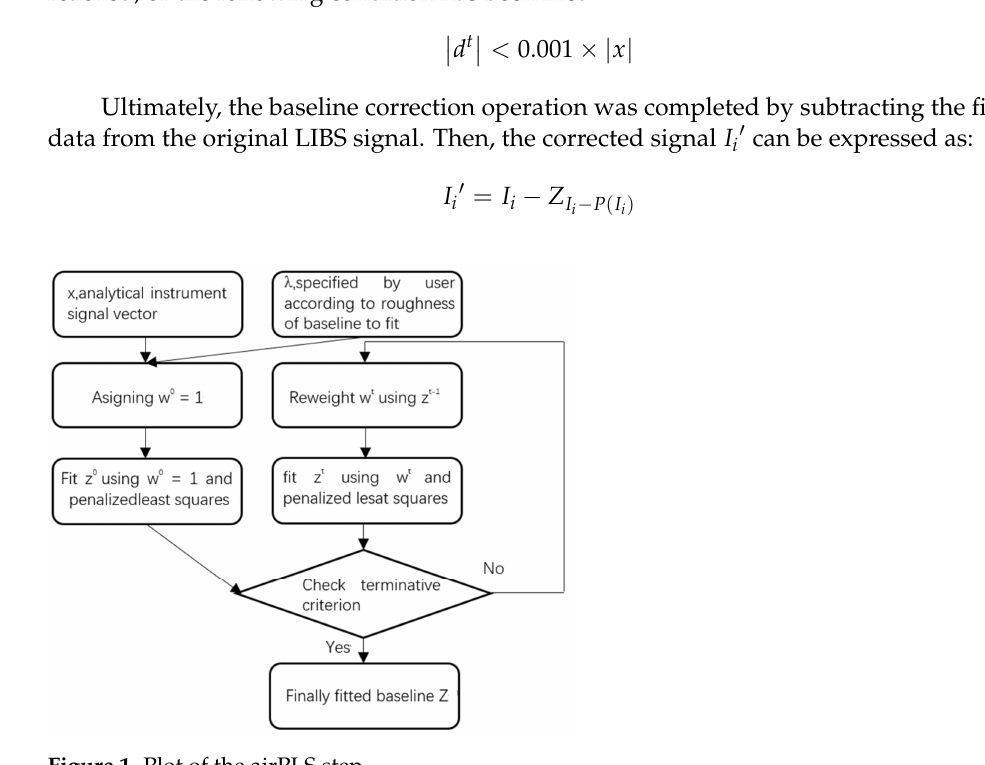
Figure 1. Plot of the airPLS step.